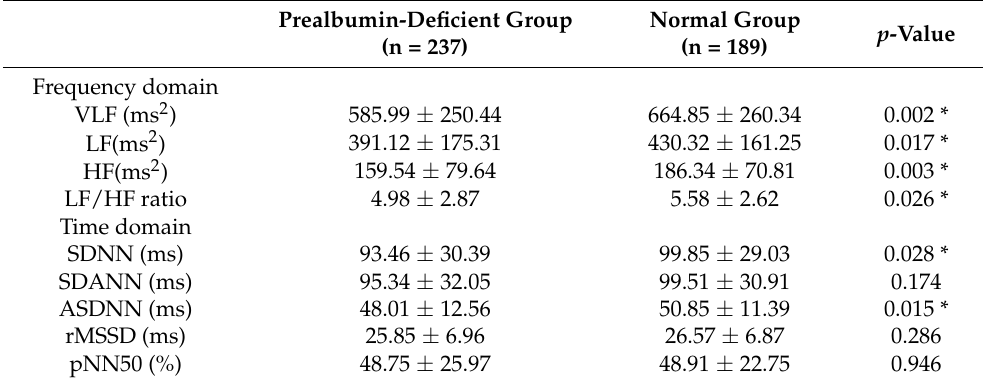
Table 3. Comparison of the HRV parameters among subgroups categorized by serum prealbu- min level.